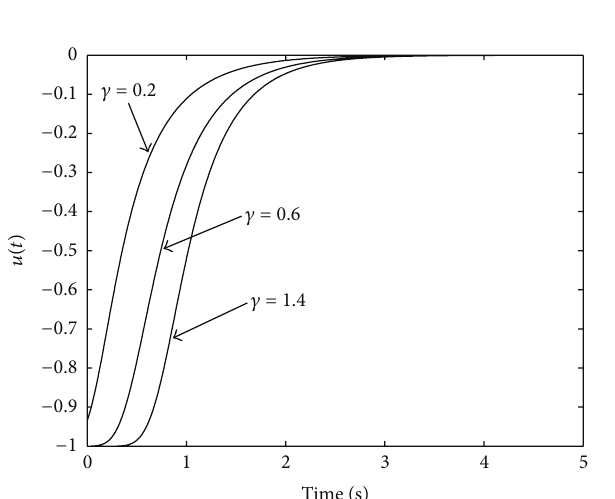
Figure 5: Evolution of the state variables.